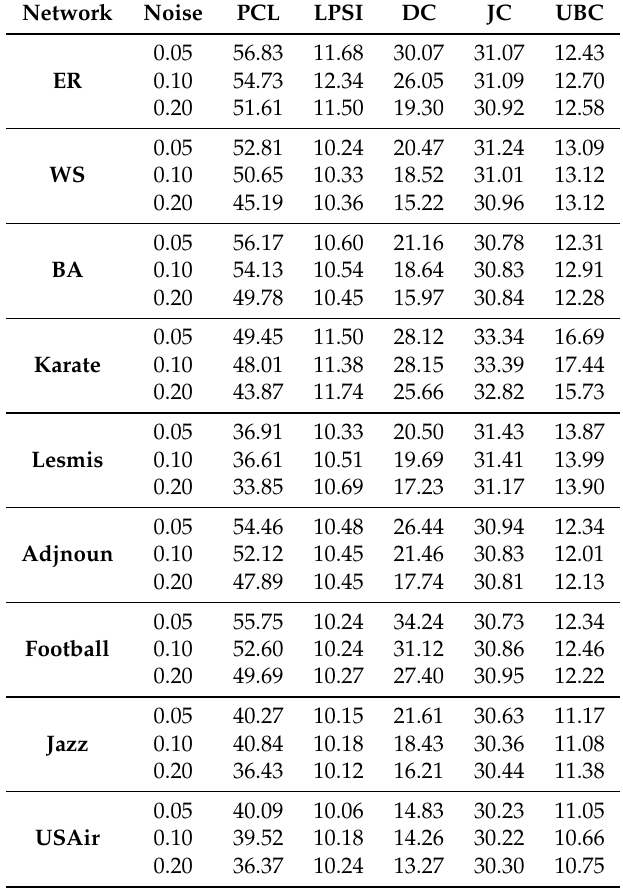
Table 3. The performance of sources localization accuracy with PCL vs. LPSI vs. DC vs. JC vs. UBC in synthetic networks and real networks under noise of various intensities. The precision is the mean value when α = 0.1:0.1:1. The number of sources is s = 3 in all networks, < k > = 4, N = 100 in the ER, WS and BA networks, the connect probability is 0.1 in the WS network. Moreover, the strategy of dealing with unknown infection information chooses